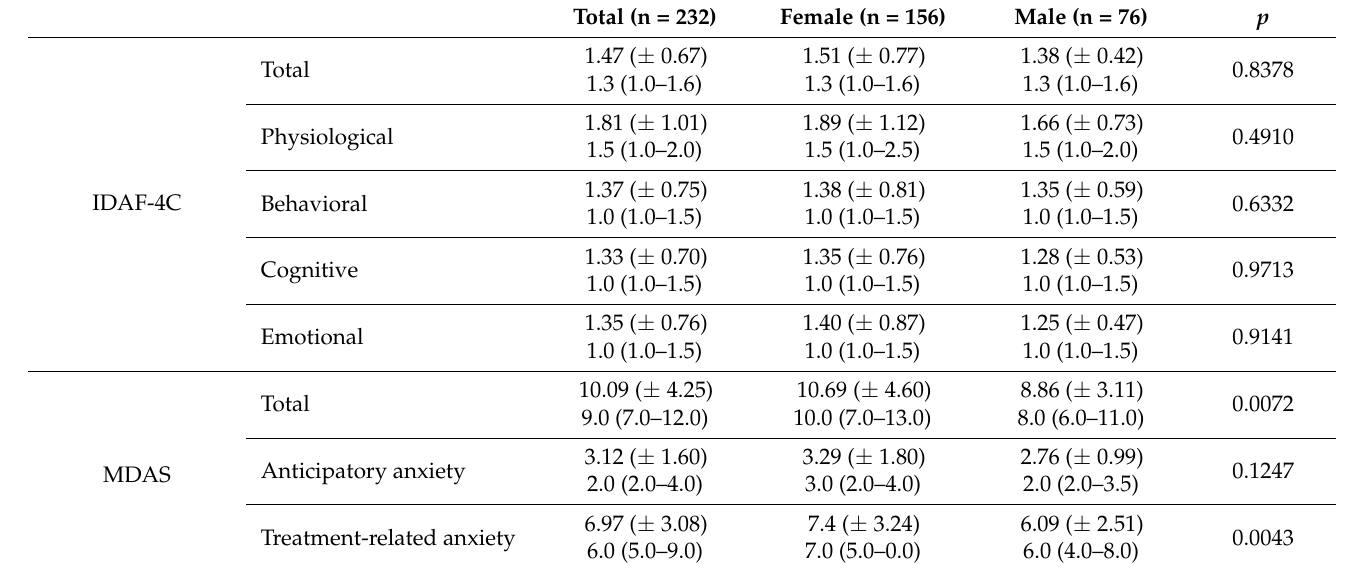
Table 4. Descriptive statistics for the IDAF-4C and MDAS by